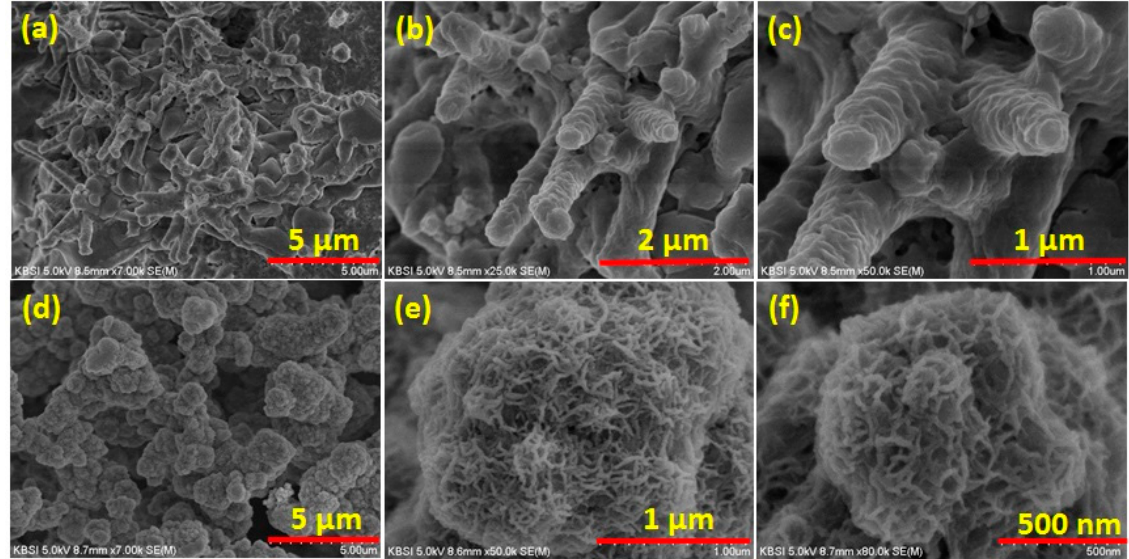
Figure 2. Low- and high magnification HR-SEM images of the ZnO/NF ( a – c ) and ZnO/CoS 2 /NF nanocomposite ( d – f ).